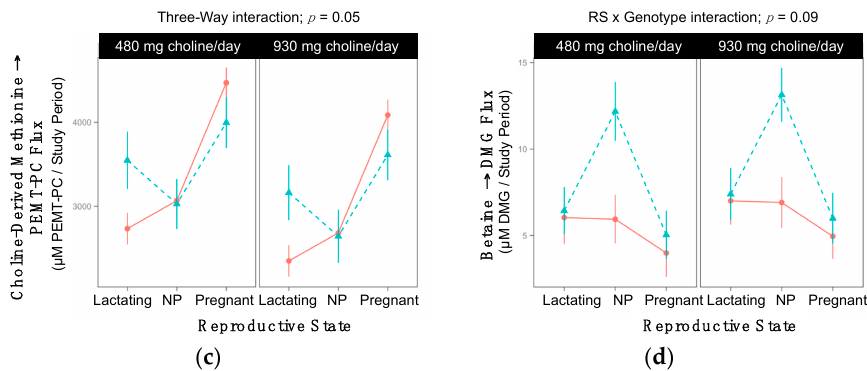
Figure 4. Effect of the CHDH rs12676 variant on the metabolic flux and partitioning of dietary choline. ( a ) PC-d 3+6 /PC-d 9 partitioning; ( b ) Choline → CDP-PC flux; ( c ) Choline-derived methionine → PEMT-PC flux; ( d ) Betaine → DMG flux. Table 6. CHDH rs12676 genotype alters plasma choline metabolite partitioning. Values are least-squared means ± standard errors for each group. PC-d3+9/PC-d9 values are ratios.